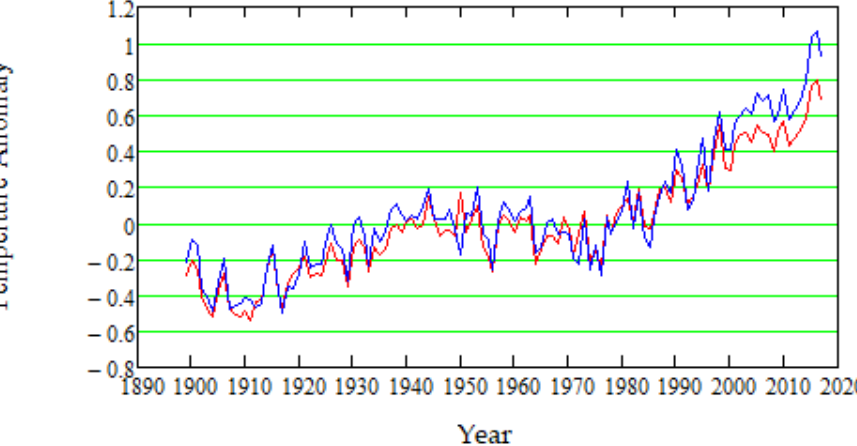
Figure 5. Annual surface temperature anomalies (°C) for the years 1850–2018 from the 1961–1990 mean obtained from [28]. The red line is global temperature and the blue line is NH temperature.